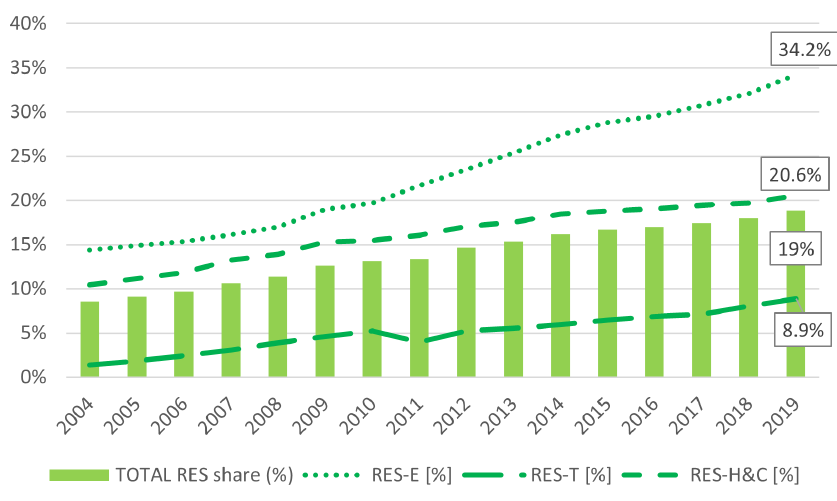
Figure 1. Renewable shares in the electricity (RES-E), transport (RES-T) and heating and cooling (RES-H&C) sectors, source: own figure based on Eurostat